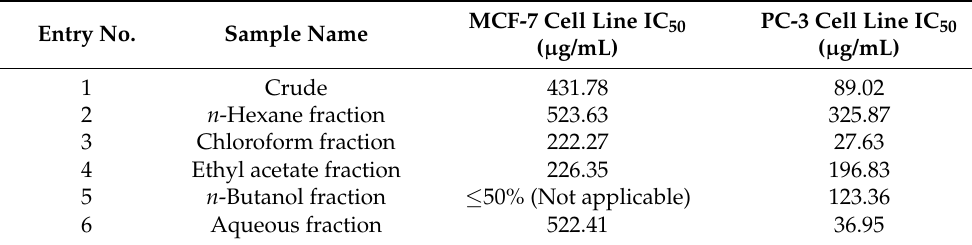
Figure 5. Presentation of growth inhibitory effects of G. velutinum extract and its fractions on MCF-7 cells. The results are expressed as a percentage of the negative control. Data are means ± SD of three independent experiments. * and *** represent p ≤ 0.05 and p ≤ 0.001, respectively. Table 5. IC 50 values of G. velutinum extract and fractions for MCF-7 and PC-3 cell lines. Entry